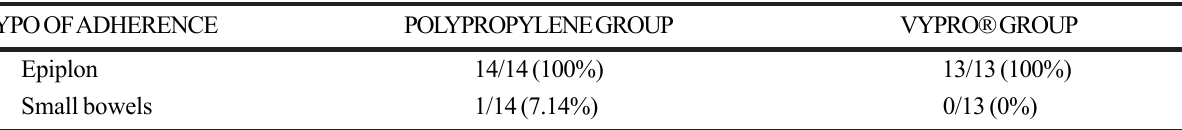
TABLE 3 - Comparison of macroscopic adherences visualized after 28 days in the polypropylene and vypro®